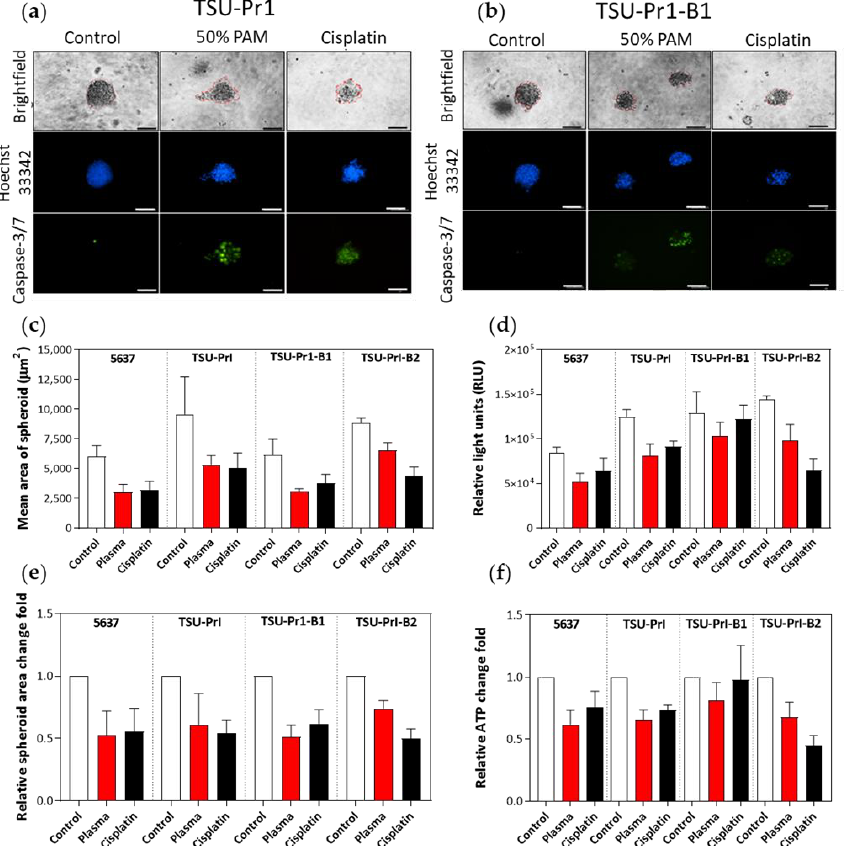
Figure 6. The 3D bladder cancer cells’ responses to PAM treatment. Representative images of spheroids from bladder cancer cell lines TSU-Pr1 ( a ) and TSU-Pr1-B1 ( b ). Treatment was performed for 6 days with control, 50% PAM, and 10 mM cisplatin. DNA was assessed with Hoechst 33342 (blue) and caspase-3/7 (green) staining using CellEvent Caspase-3/7 dye. Scale = 100 µ m. ( c ) Area of spheroids from cell lines; control, treated with 50% PAM, or treated with 10 mM cisplatin (to mimic treatment of MIBC). SD calculated from the area of 5–10 spheroids. Only spheroids with ~>50 cells were counted. ( d ) Overall ATP production of treated bladder cancer cell line organoids was used as a measure of cellular viability, measured as RLU using the CellTiter-Glo 3D Cell Viability Assay following treatment. Average of 3 technical replicates normalized to background luminescence. ( e ) The relative fold change in spheroid area, representing the normalized data of ( c ). ( f ) The relative fold change in ATP levels, representing the normalized data of ( d ). These results are from a single pilot experiment with 10 spheroids for each treatment